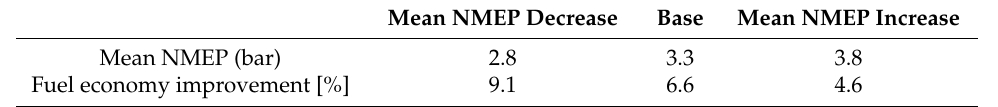
Table 6. Summary of fuel economy improvement by mean NMEP in FTP-75.